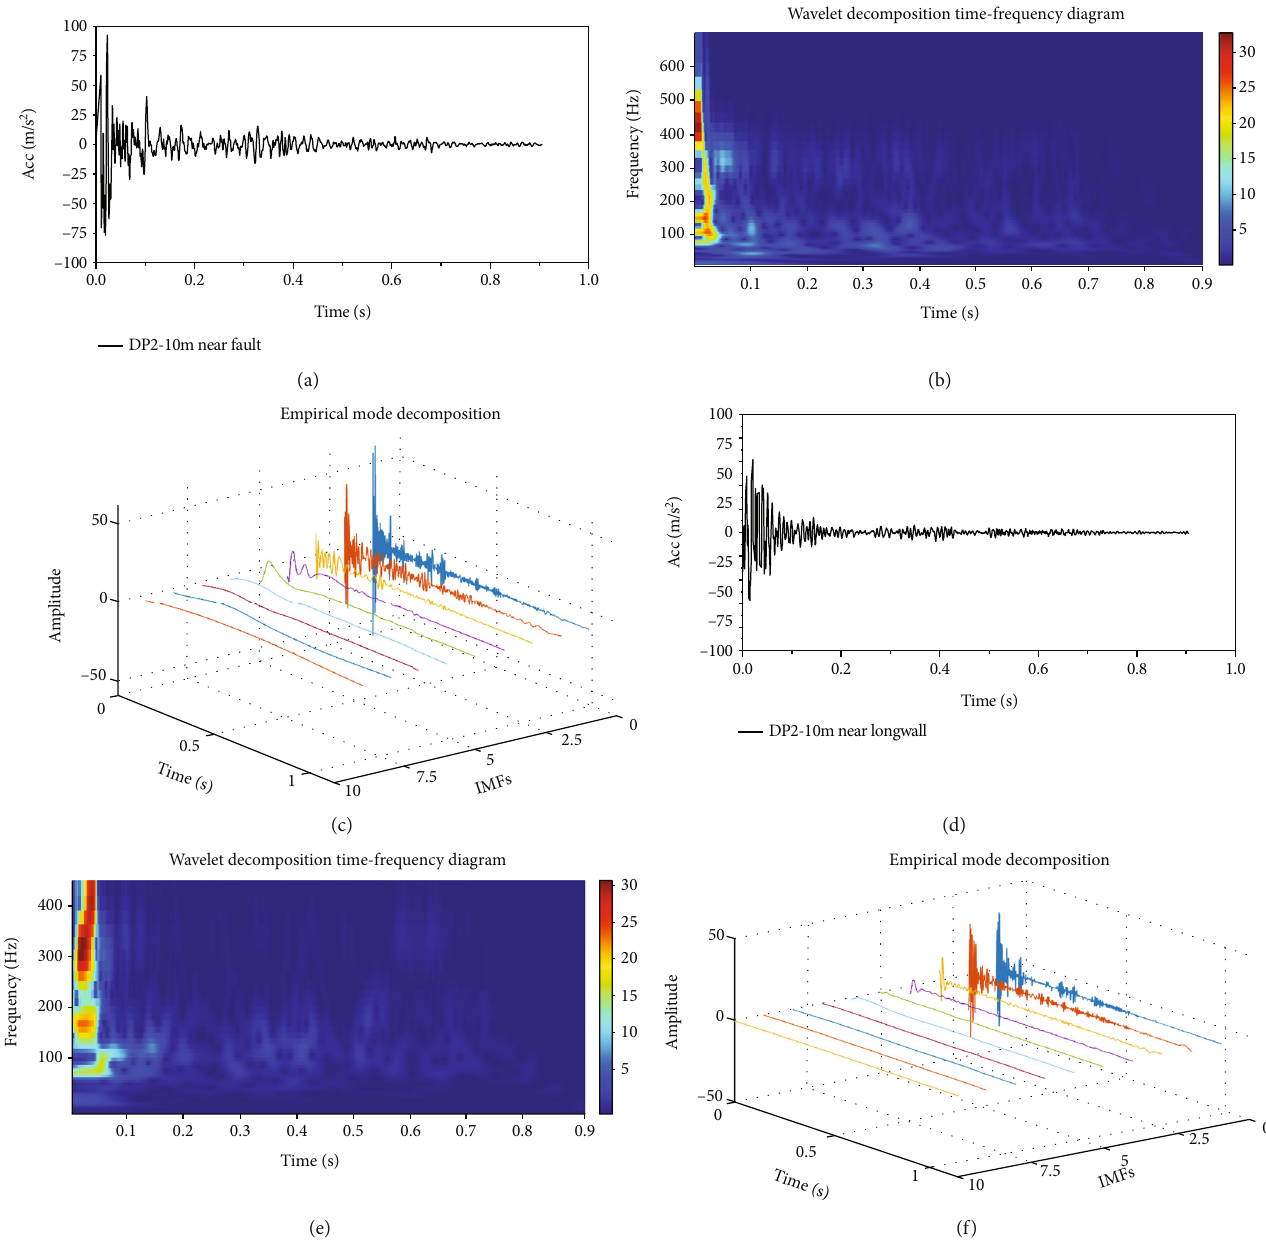
Figure 14: Vertical acceleration, wavelet decomposition time – frequency, and EMD maps of the monitored working face and the vicinity of the fault when the longwall working face is 10m away from the fault under